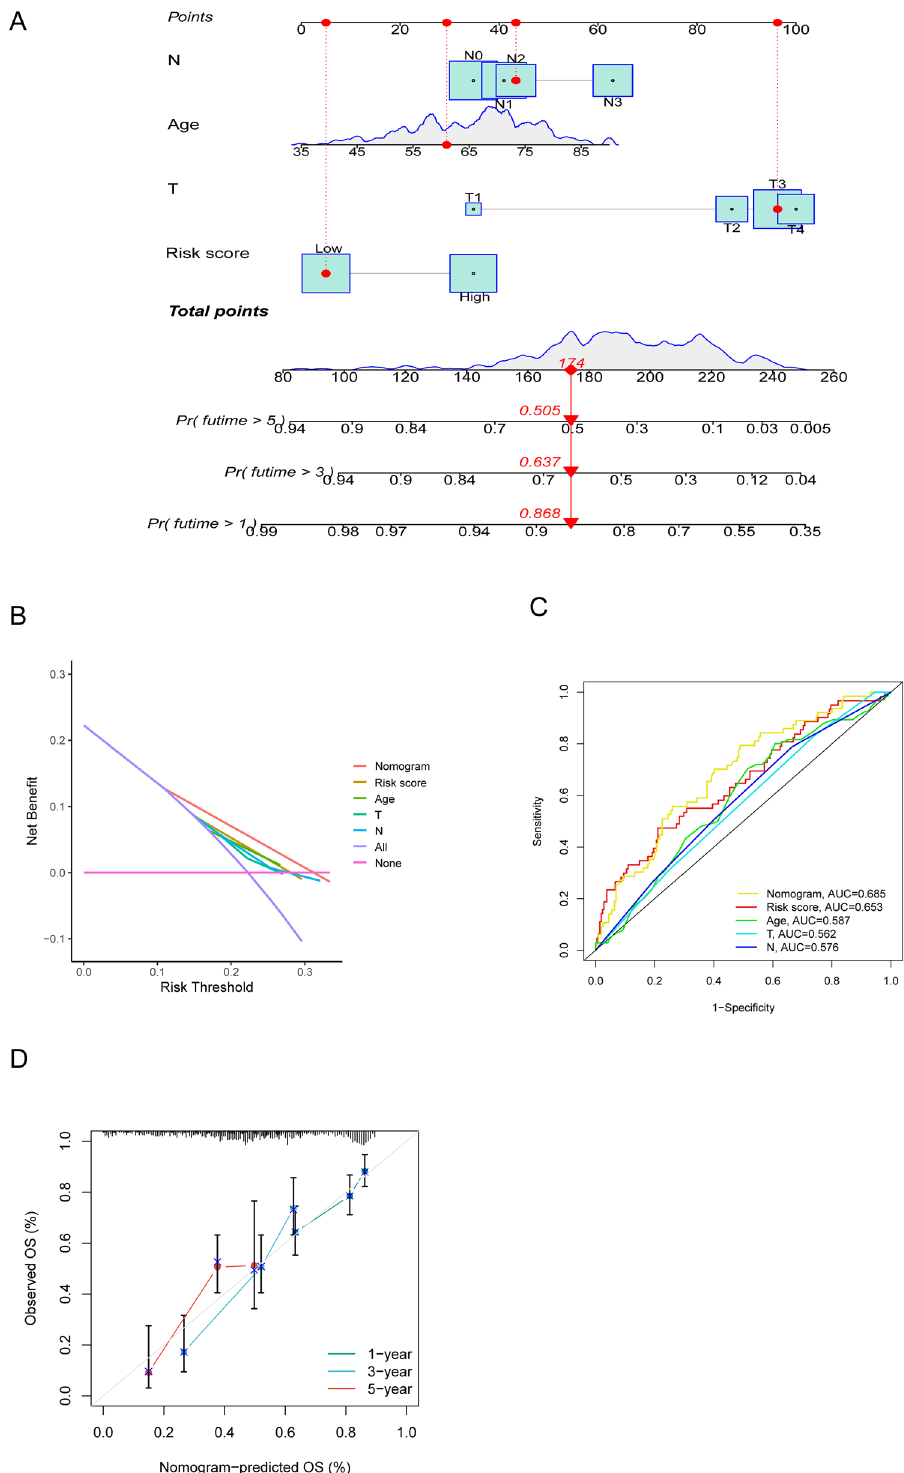
Figure 9. The construction and assessment of nomogram. ( A ) Nomogram integrating clinical factors and risk score for predicting 1-, 3-, and 5-year OS in TCGA-GC cohort ( B ) Decision curves of risk score, nomogram, and single clinical factors including T stage, N stage and age. ( C ) The time-dependent ROC curves of risk score, nomogram and single clinical factors including T stage, N stage and age. ( D ) The calibration curves for 1-, 3-, and 5-year OS. OS, overall